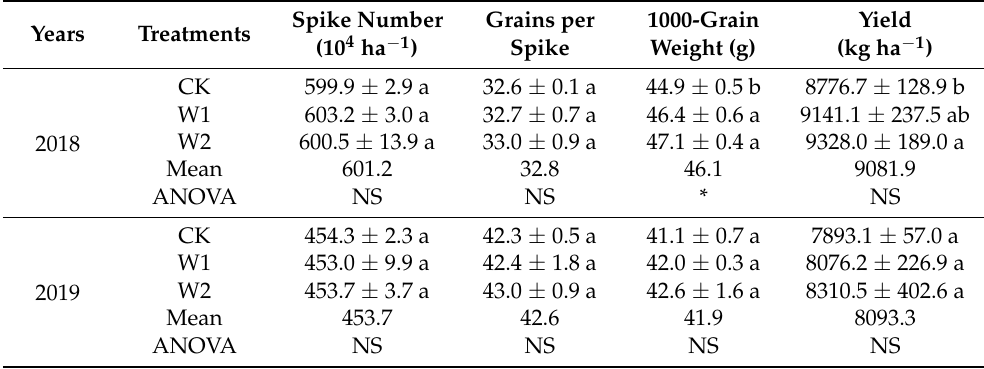
Table 1. Grain yield and yield components under different treatments in 2018 and